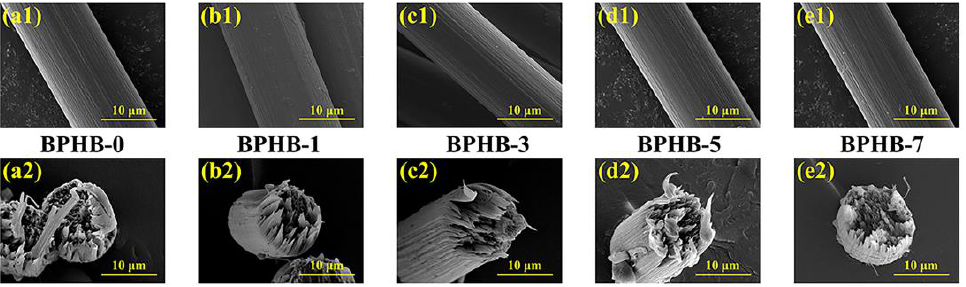
Figure 3. SEM images of the surface ( a 1 – e 1 ) and cross-section ( a 2 – e 2 ) of PI fibers.